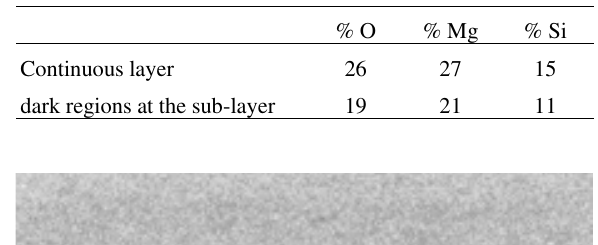
Table 2. EDS data for the film formed by MgO + 1%Sr. Table 1. EDS data for the film formed by MgO.